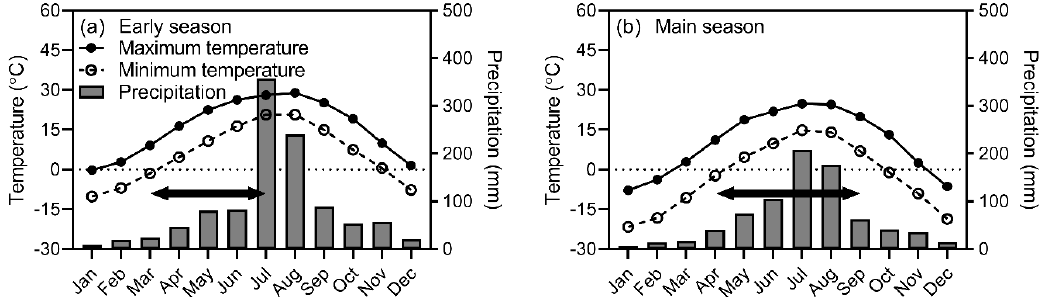
Figure 2. Monthly maximum and minimum temperature and monthly total rainfall for the early ( a ) and main ( b ) season potato regions. All values are area-weighted averages. Arrows indicate the growing season of potatoes.